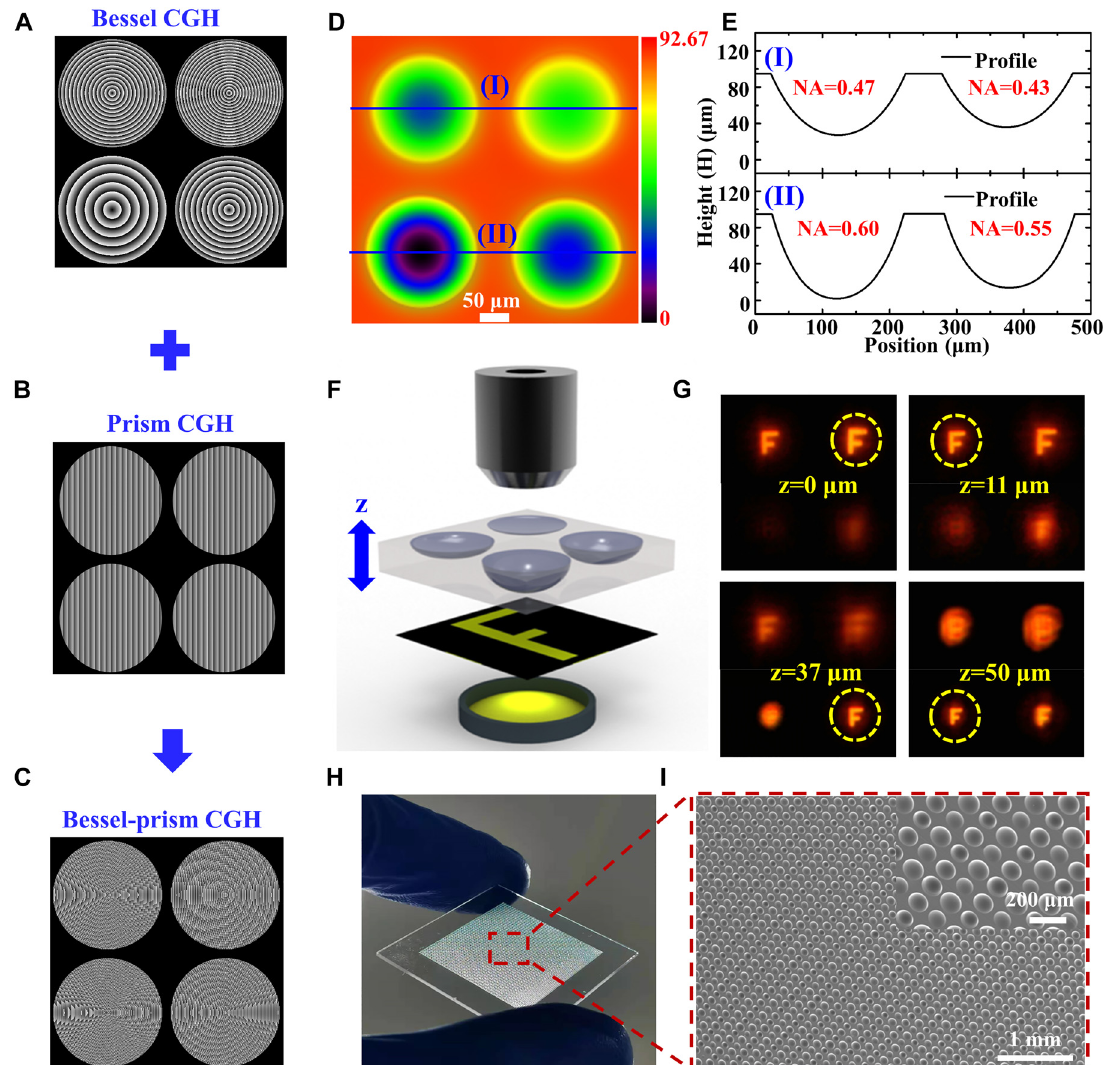
Figure 5: The designed Bessel-prism CGH was loaded into SLM to fabricate the MLA with multiple NAs, and the multi-plane imaging performance of the MLA was